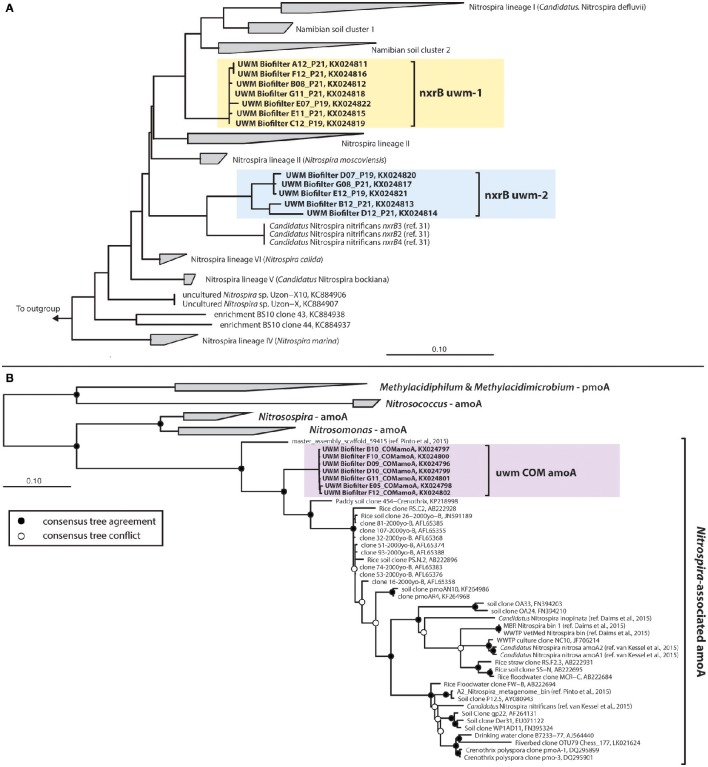
Consensus phylogenetic trees for Nitrospira-like (A)
nxrB and (B)
amoA genes. For the nxrB phylogeny, the consensus tree from Pester et al. (2014) is illustrated. The UWM Biofilter and Candidatus Nitrospira nitrificans sequences were added to this phylogenetic reconstruction with the Quick-Add Parsimony tool of the ARB package (Ludwig et al., 2004), so as not to change the tree topology. For the amoA phylogeny, a consensus phylogenetic tree was generated from maximum likelihood and Bayesian inference phylogenetic reconstructions. Consensus tree support is indicated by colored circles at tree nodes. Clone names are followed by NCBI accession numbers or a manuscript citation. In both trees, sequences generated in this study are highlighted with colored boxes.